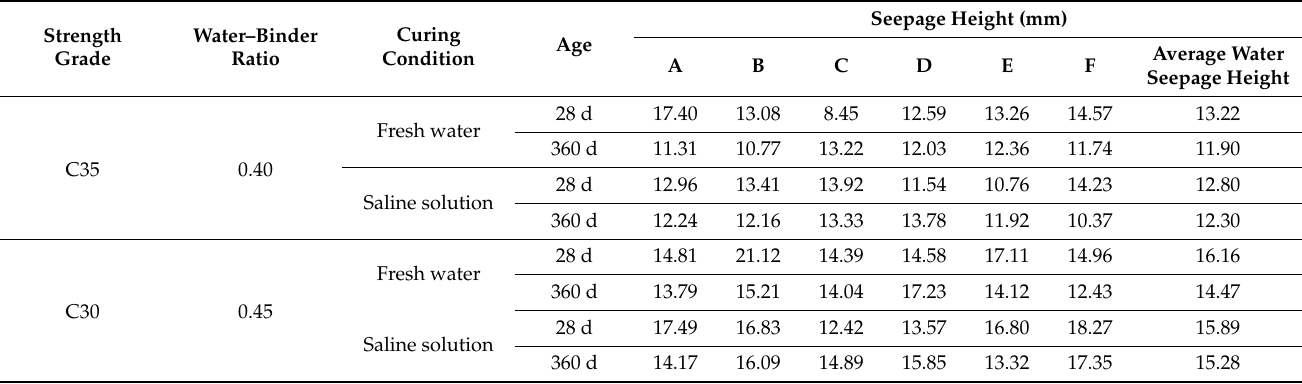
Table 3. Concrete water penetration height test results.